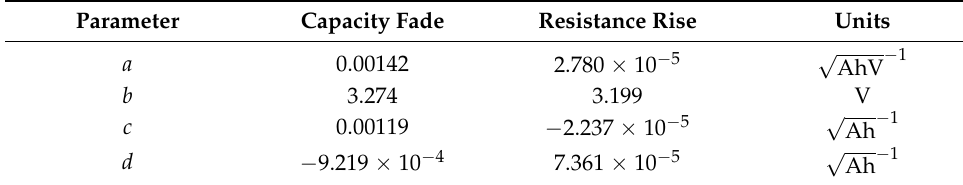
Figure 6. Schematic of the cell replacement simulation framework. Table 3. Degradation parameters used in the